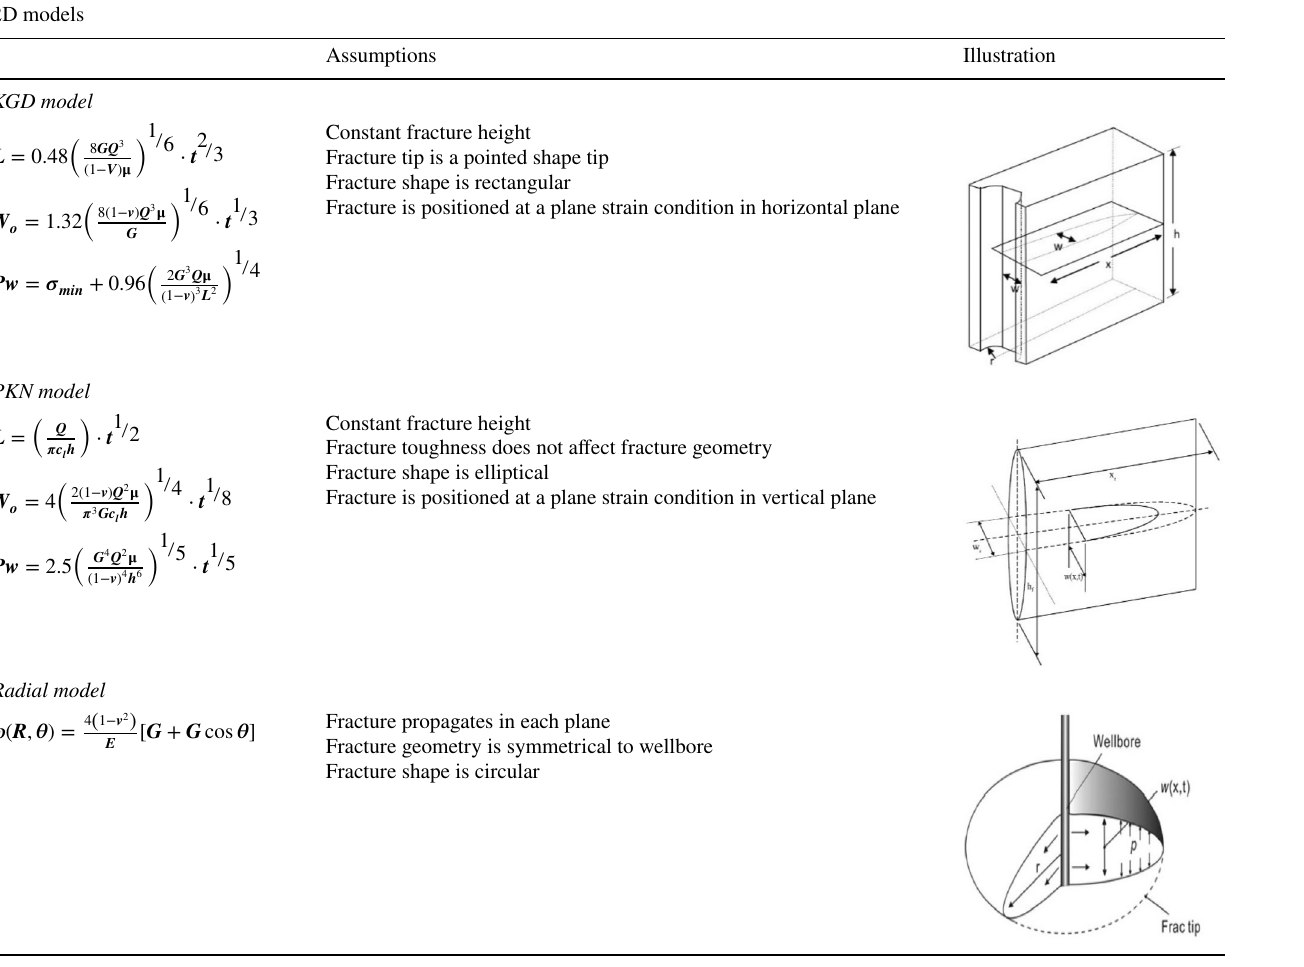
Table 1 Summary of the available analytical models (Rahman and Rahman 2010; Xiang